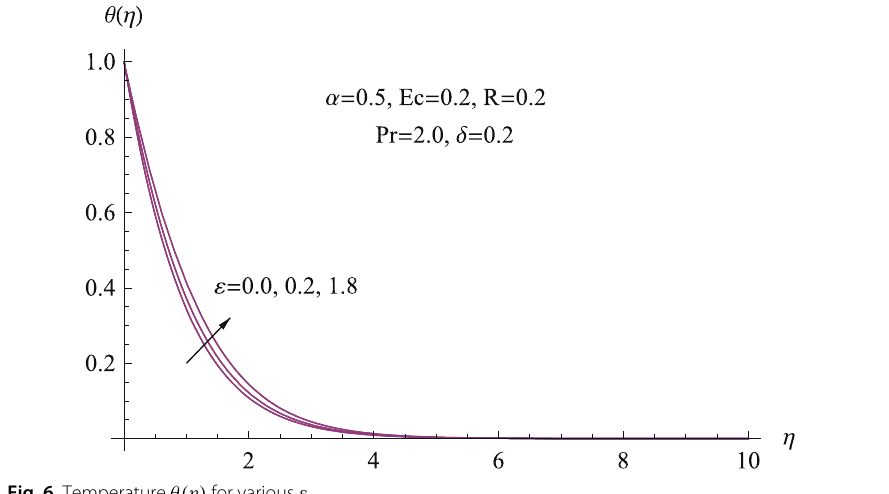
Fig. 6 Temperature θ(η) for various